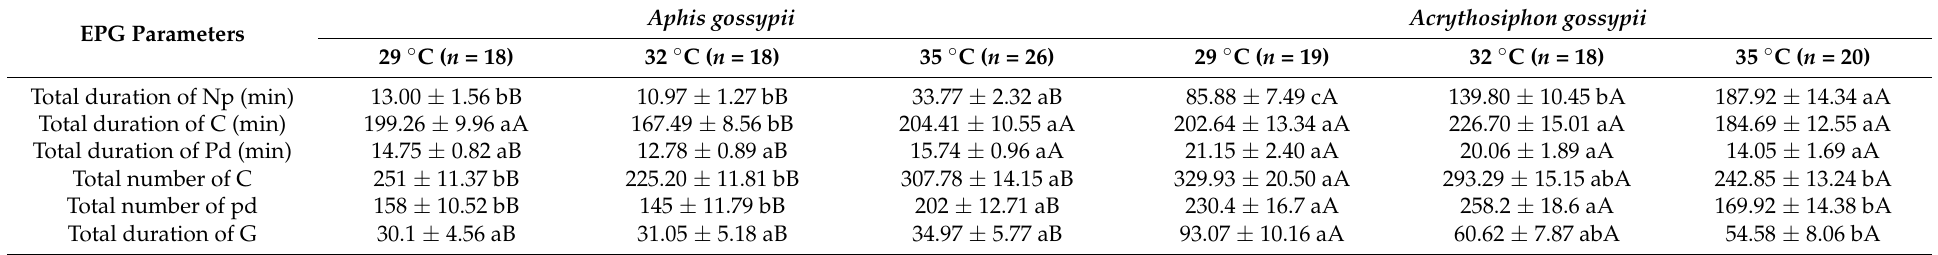
Table 1. Comparison of electrical penetration graph (EPG) parameters of Aphis gossypii and Acyrthosiphon gossypii in the non-phloem phase under different temperatures.